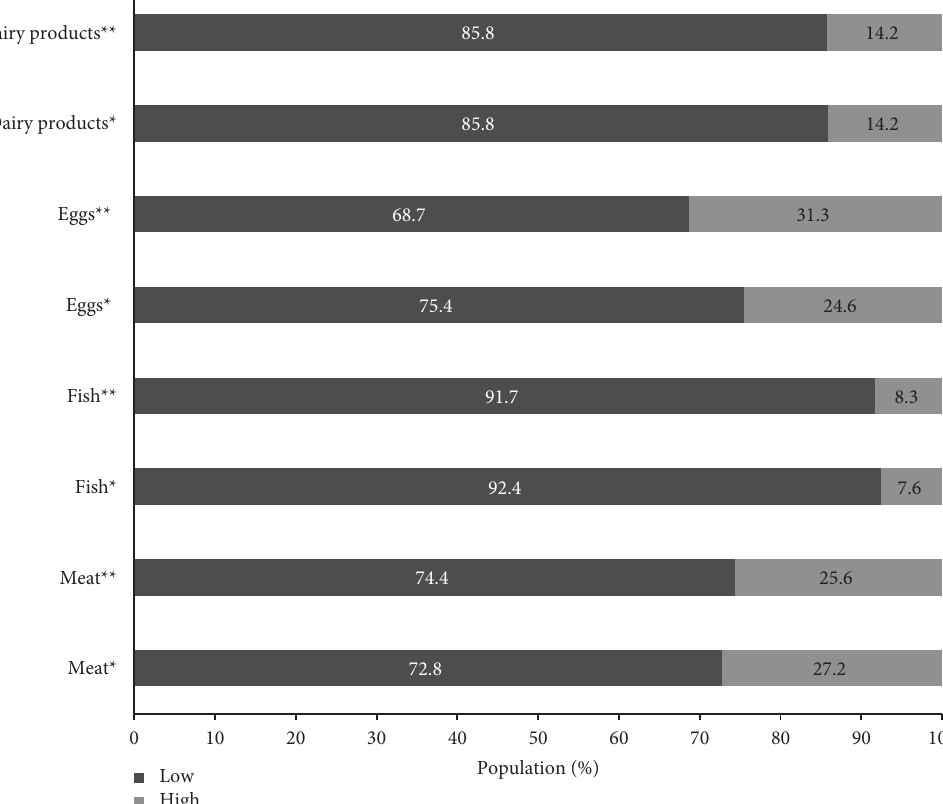
Figure 3: Changes in the frequency of low and high consumption of animal-based foods before and during social isolation. ∗ Before social isolation; ∗∗ during social